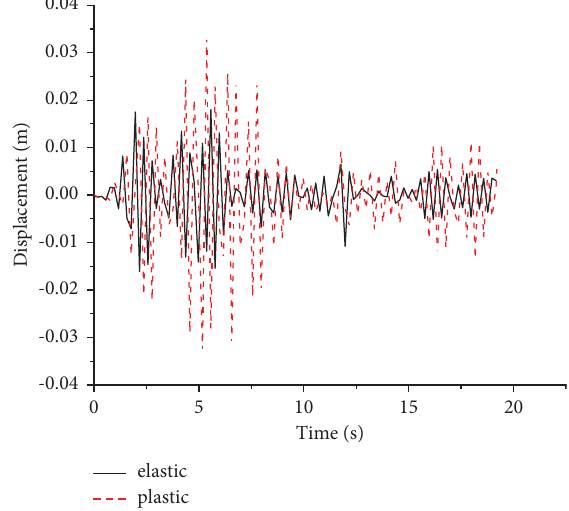
Figure 14: Time-history curve of displacement in the second